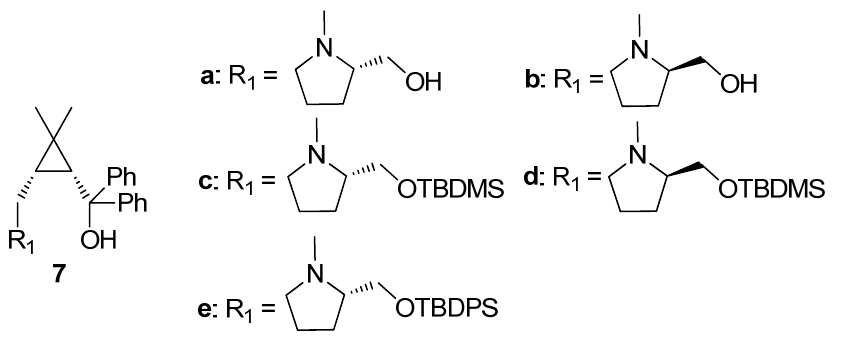
Figure 2. Cyclopropane amino alcohol 7a – e